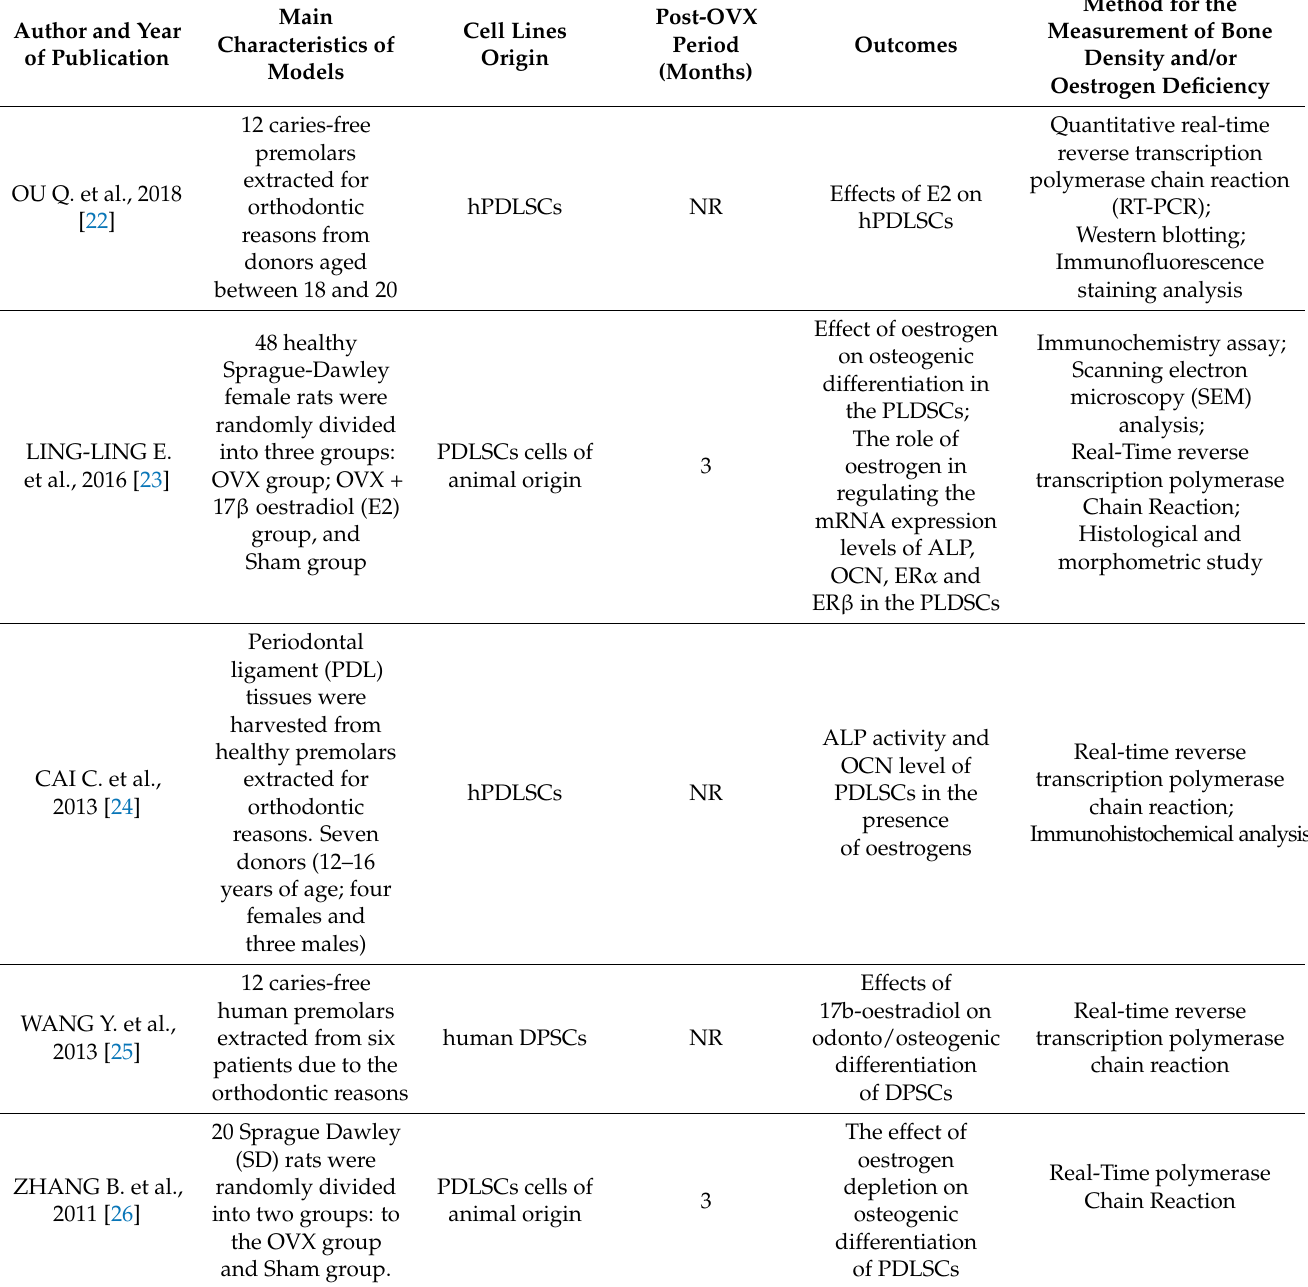
Table 1. Characteristics of the included